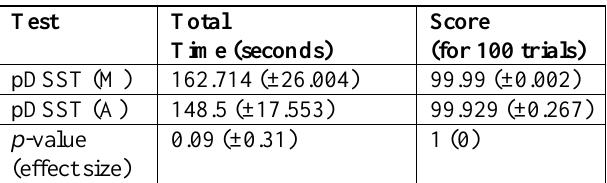
Table 5 pDSST test performance metrics (Average±SD) for the morning (M) and afternoon (A) sessions. Note: The score for pDSST is out of 100.